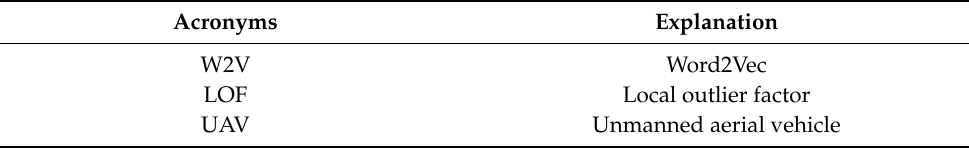
Table A1. List of